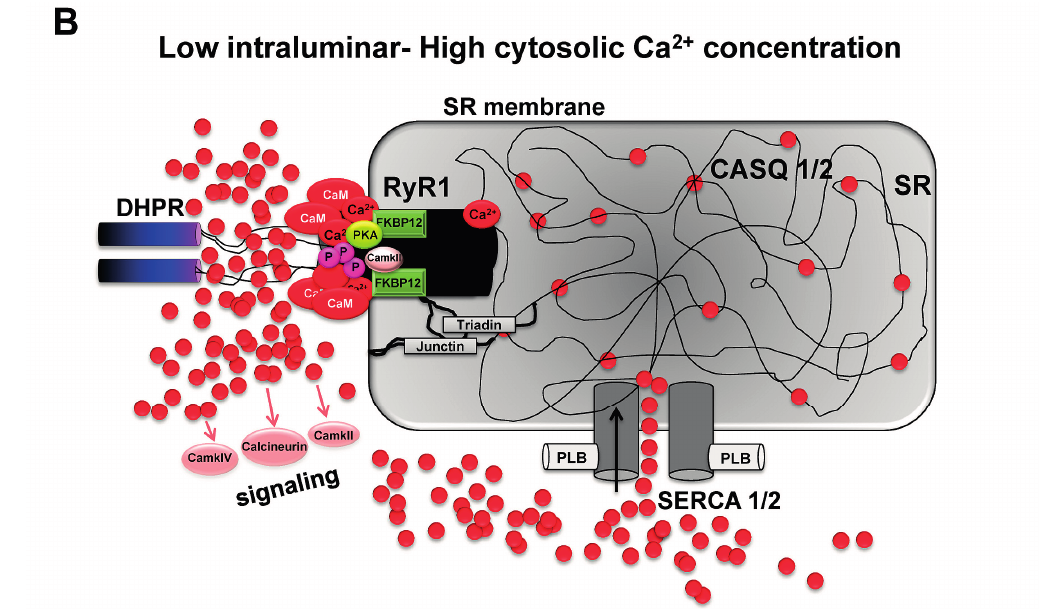
Figure 2. RyR1 channels induce rapid and high gradients in Ca 2+ ion concentration between luminal compartments of the SR and surrounding sarcoplasm of myofbrills. ( A ) RyR1 opening is primarily controlled by the voltage dependent activation of DHPR which mechanically interacts with RyR1 and regulates channel opening (voltage gating). Further and adjacent RyR1 channels are opened by voltage-independent RyR1-RyR1 interactions (coupled gating) which create locally high Ca 2+ ion gradients. On the luminar side of the SR, RyR1 channel opening is supported by the combined mechanical interaction with triadin, junctin and the SR membrane. High Ca 2+ ion concentrations in the SR further supports channel open probability. On the sarcoplasmic side and at low Ca 2+ concentrations, high amounts of Ca 2+ unbound apoCaM supports increased open probability and activity of RyR1 while Ca 2+ -activated CaM inhibits RyR1. PKA and CaMKII have binding sites on RyR1 subunits and are able to phosphorylate RyR1 and modulate channel activity; and ( B ) Upon elevation of sarcoplasmic Ca 2+ levels due to RyR1 channel opening, decreased Ca 2+ ion levels in SR inhibit RyR1 channel activity. Sarcoplasmic Ca 2+ levels increase CaM levels which activate CaMKII, IV and calcineurin. CaM inhibits RyR1 channel activity on the sarcoplasmic side of RyR1 while CaMKII binds to and phosphorylates RyR1. Hyperphosphorylation of RyR1 via PKA and CaMKII may lead to increased dissociation of FKBP12, higher open probability of RyR1 channels and decreased contractility of skeletal muscle under resting conditions. Increased SERCA activity facilitates rapid reuptake of Ca 2+ ions into the